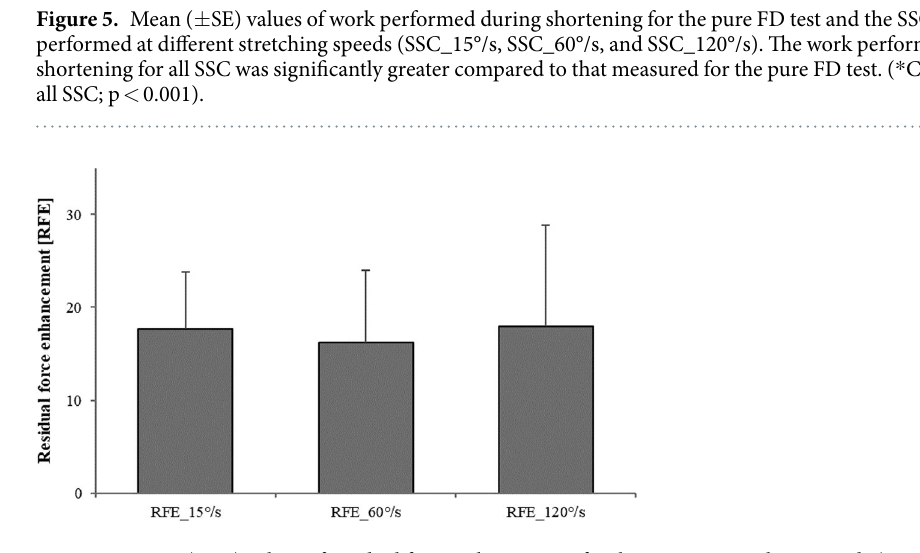
Figure 6. Mean ( ± SE) values of residual force enhancement for the varying stretching speeds (RFE_15°/s, RFE_60°/s and RFE_120°/s) normalized to the values of the isometric reference contraction at the corresponding thumb angle. Residual force enhancement values were similar (p > 0.05) across the different stretch speeds (17.7% ± 1.7%, 16.2% ± 2.2%, 17.9% ± 3.1% for RFE_15°/s, RFE_60°/s, and RFE_120°/s,